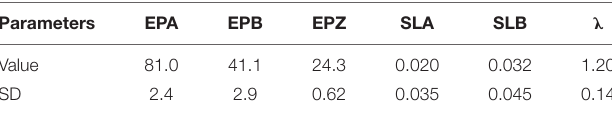
TABLE 1 | Parameters of the normal observer: EPA (unit: degree/ √ degree/ dB ), EPZ (unit: dB), SLA (unit: dB/degree), SLB (unit: dB/degree), and λ . Parameters